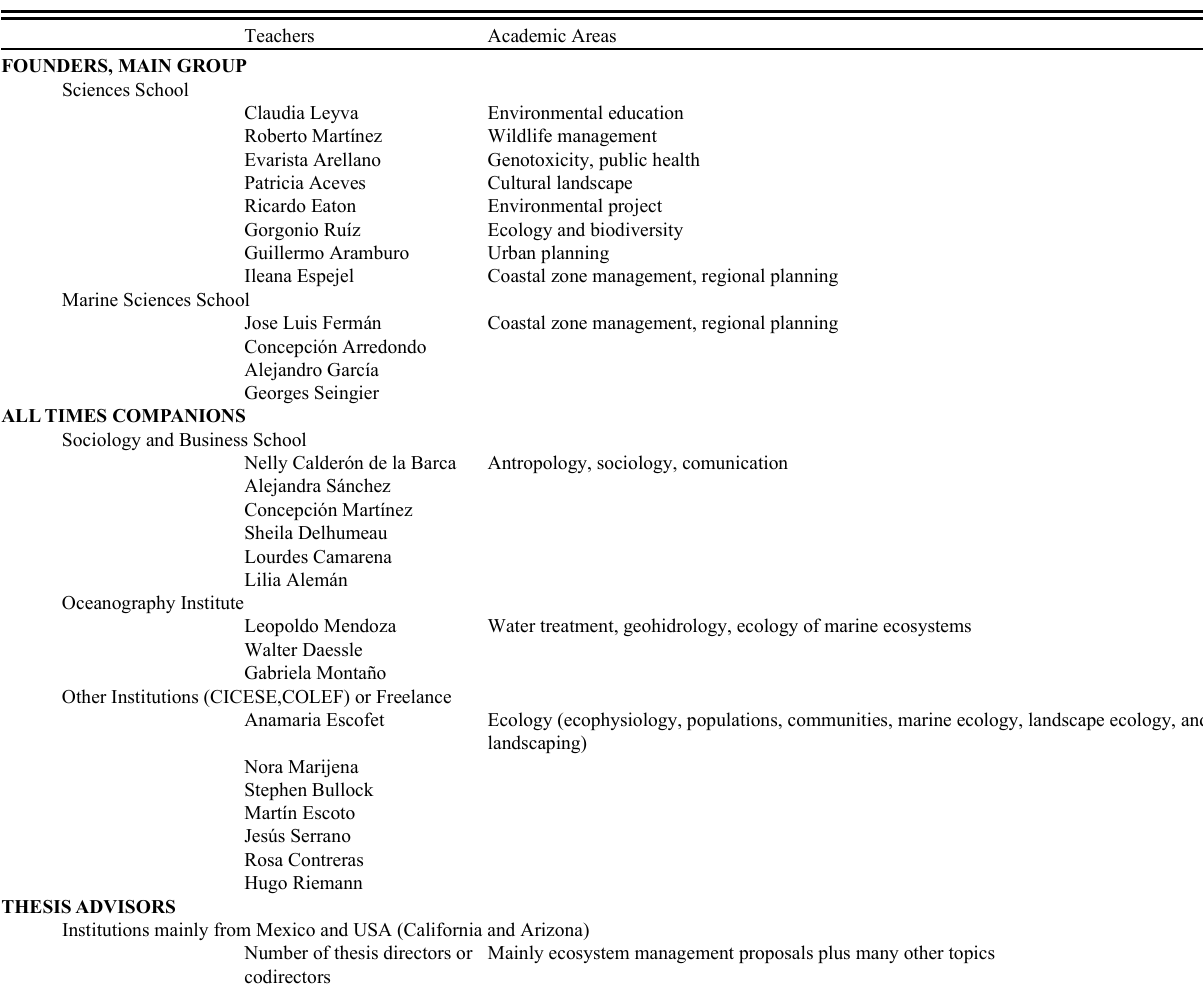
Table 1. MEZA Teachers.